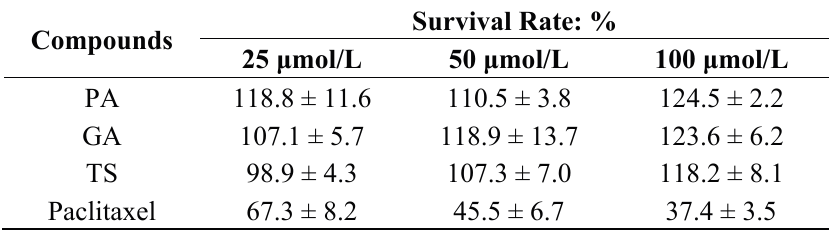
Table 1. Survival rates of Caco-2 cells treated with test compounds (n =